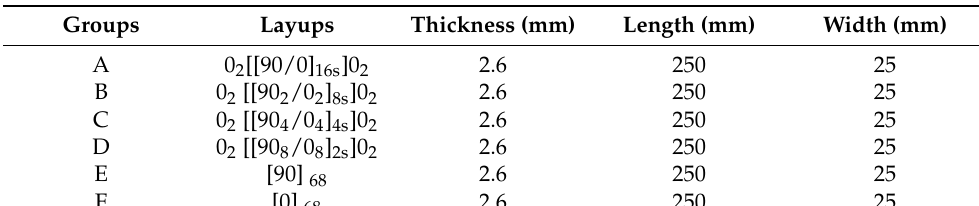
Table 1. Layer design and dimensions for tensile testing.